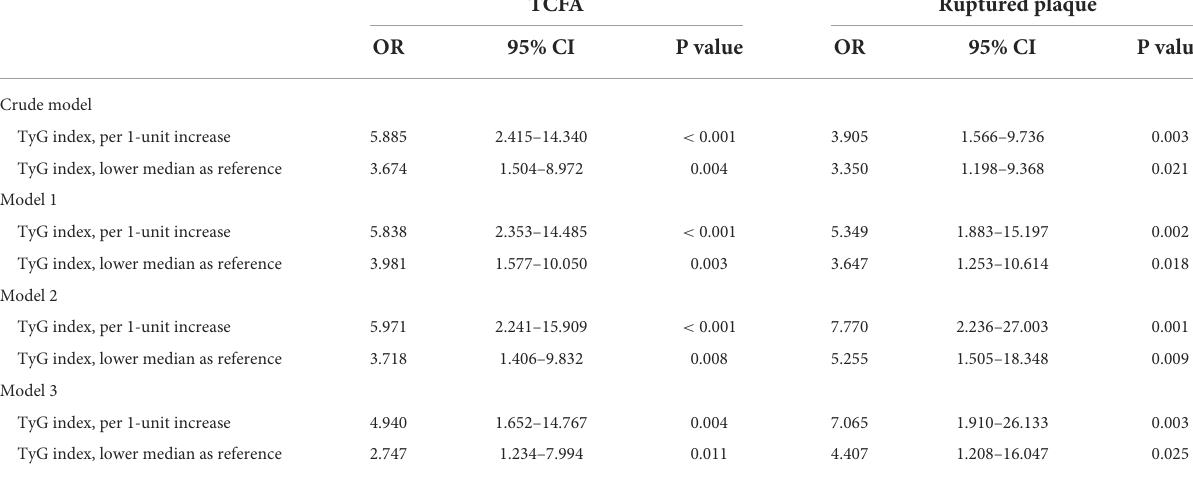
TABLE 4 Univariate and multivariate analysis evaluating the association of TyG index with non-culprit TCFA and ruptured plaque. TCFA